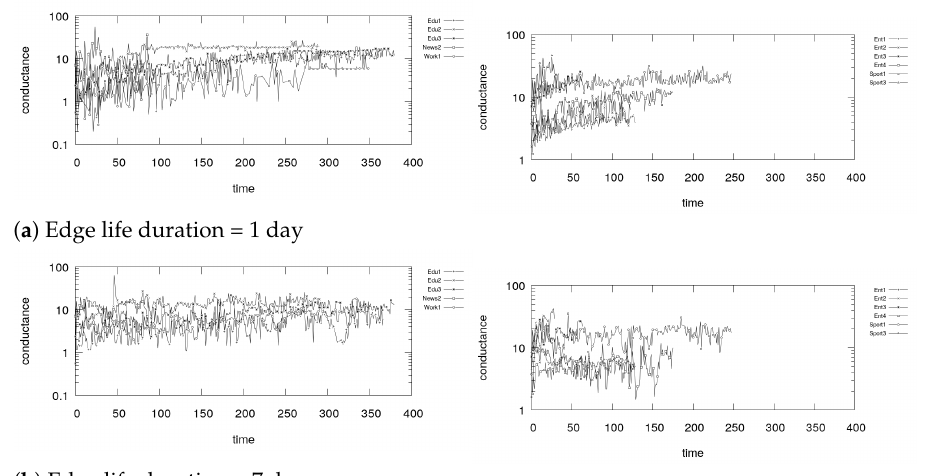
Figure 26. Conductance of communities detected by DEMON.